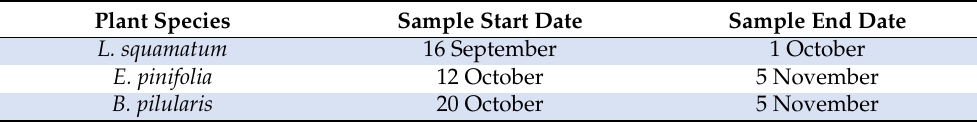
Table 1. Bloom periods of L. squamatum , E. pinifolia, and B. pilularis at the Bernard Field Station in